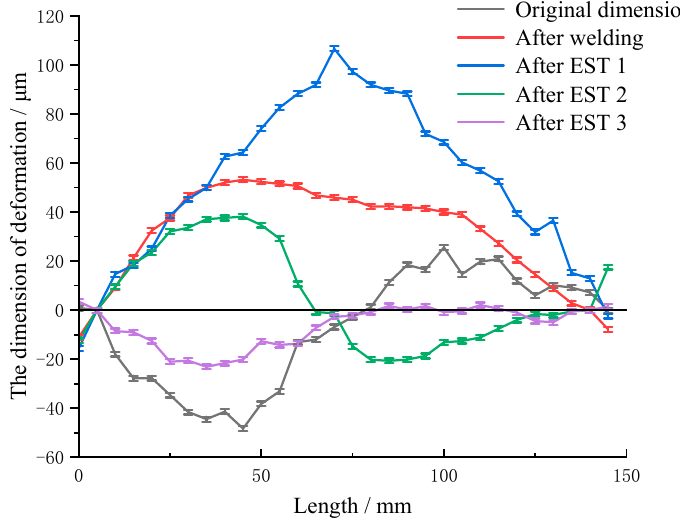
Figure 13. Levelness changes at the bottom of the B-pillar.